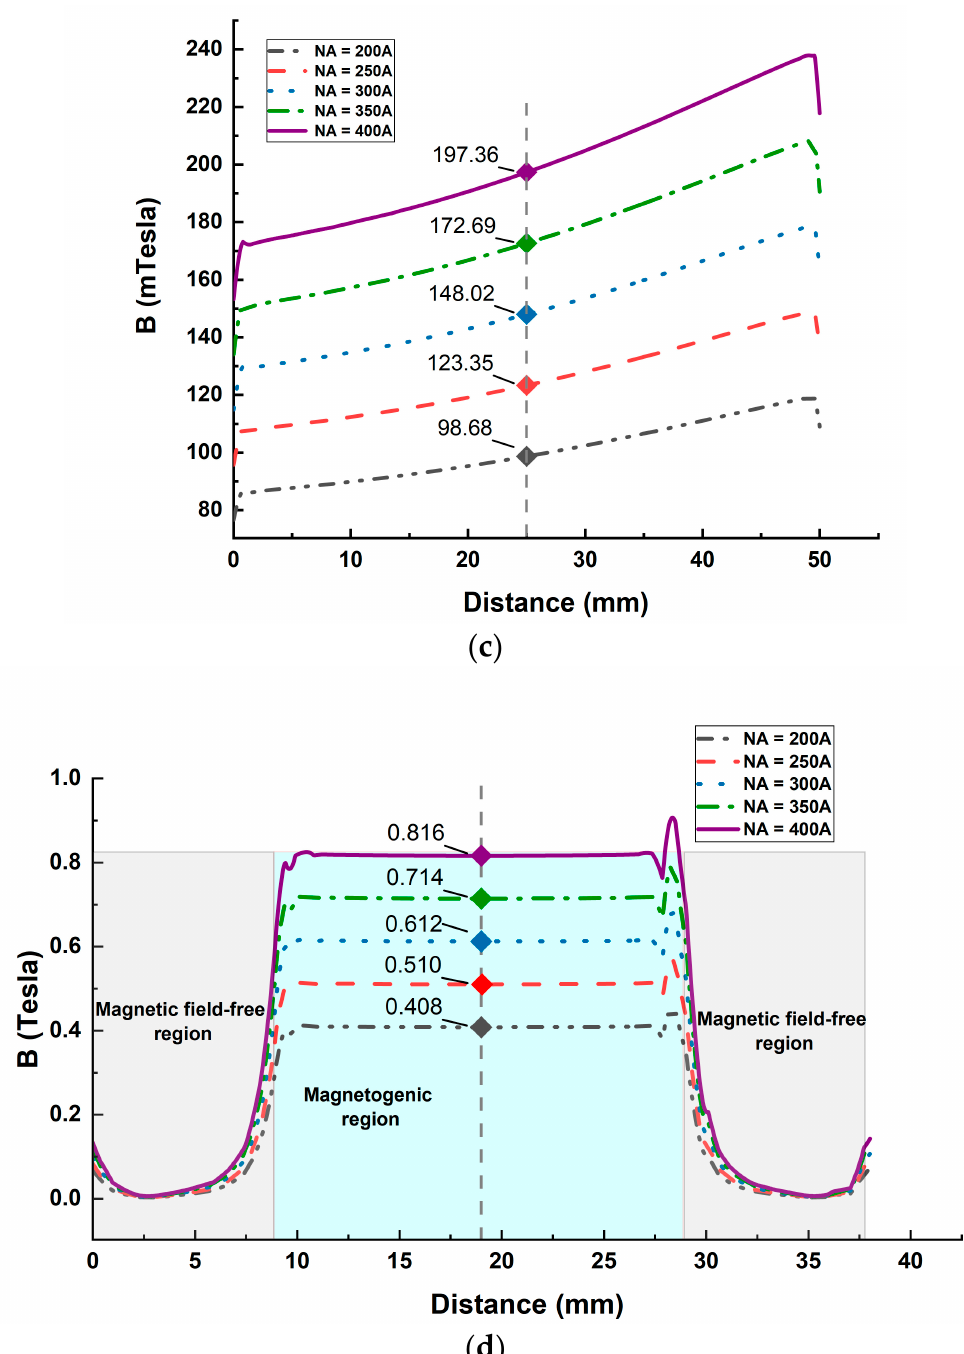
Figure 10. Magnetic field analysis of axial multi-coil configuration: ( a ) distribution diagram of magnetic field lines; ( b ) magnetic flux density distribution diagram; ( c ) magnetic field strength distribution in the path where point P is located; ( d ) magnetic field strength distribution in the path where point Q is located. Table 4. The comparison of fi nite element simulation and modeling calculation results of axial multi- coil con fi guration.